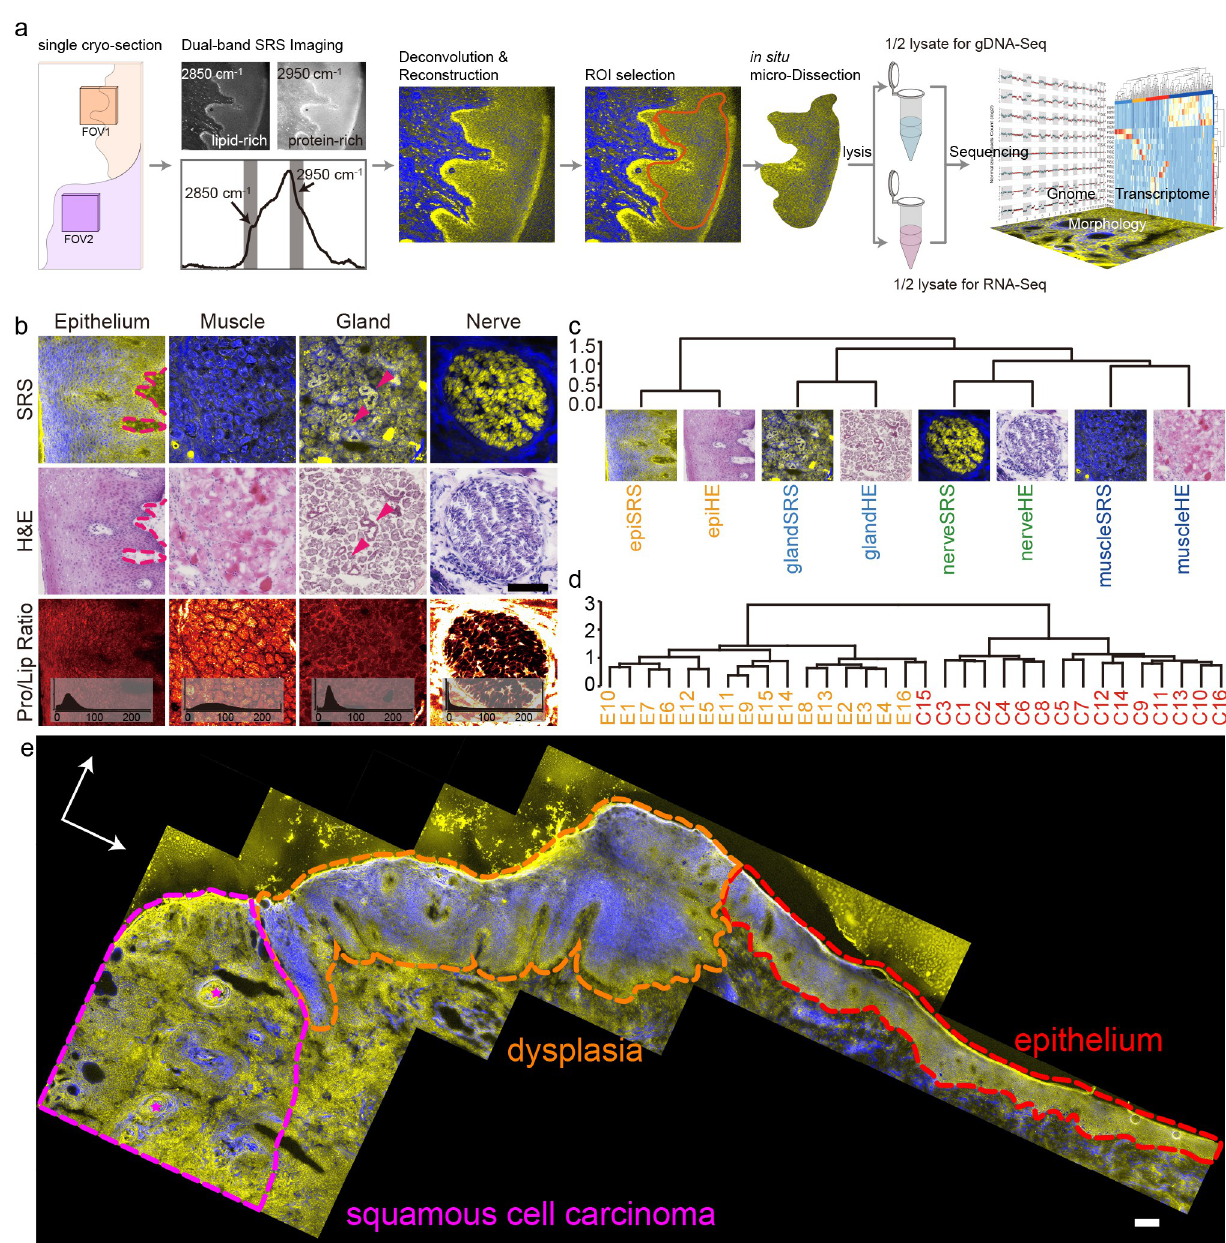
Fig 1. Principle of SMD-seq and evaluation of SRS imaging. AU : AbbreviationlisthavebeencompiledforthoseusedinFigs 1 (cid:0) 4 ; S 1 (cid:0) S 3 ; S 6 ; S 9 ; S 17 ; andS 26 : Pleaseverifythatallentriesarecorrect : (a) The pipeline of SMD-seq, inset of FOV2 represents the complexity around single cancer nest. (b) The comparison between SRS and HE AU : PleasenotethatasperPLOSstyle ; H & Eisnotallowed : Hence ; allinstancesofH & EhavebeenreplacedwithHE : images of different tissues, with the PLR images of SRS. (c) Unsupervised clustering of HOG features of SRS and HE images from different tissue types. (d) Unsupervised clustering of SRS images of epithelium and cancer. (e) Stitched SRS image of a whole sample, showing revealed morphologies including cancer, dysplasia, and epithelium. The magenta stars indicate the keratin pearls. Scale bars are 200 μ m. HE, hematoxylin–eosin; HOG, histogram of orientation gradient; PLR, protein-to-lipid ratio; SMD-seq, SRS microdissection and sequencing; SRS, stimulated Raman scattering. variation in cellular phenotypes over small length scales [25,26]. OSCC cancer nests, for exam- ple, measuring as small as 100 μ m in diameter, are often interlaced with normal tissues com- posed of noncancerous cells, and it is challenging to dissect this heterogeneity with existing methods [25]. Additionally, mutation patterns in OSCC have been shown to differ from other